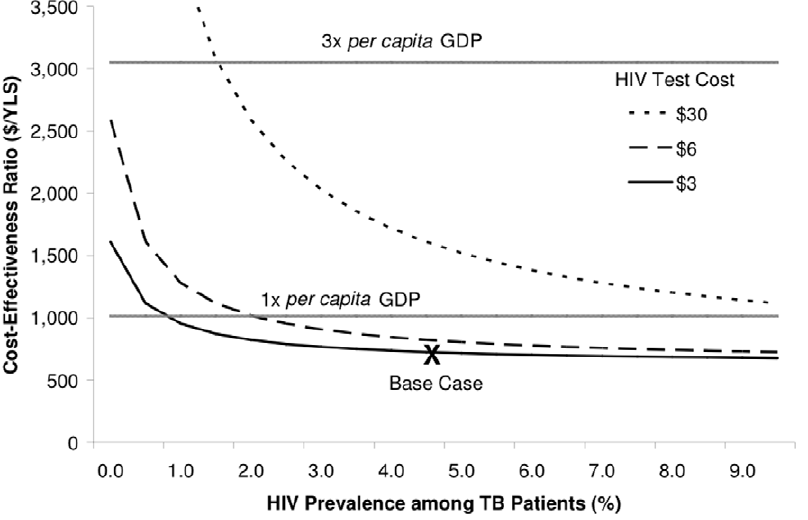
Figure 1. Sensitivity analysis on HIV prevalence among TB patients. The cost-effectiveness of routine referral for HIV testing for all TB patients (Strategy 3) compared to the current standard of referral for HIV testing for TB patients in the nine states with the highest HIV prevalence and selective referral elsewhere (Strategy 2), as a function of HIV prevalence and HIV test cost. The 3x and 1x per capita GDP for India represent thresholds for ‘‘cost-effective’’ and ‘‘very cost-effective’’ health care interventions, as recommended by the WHO (See Methods). GDP: Gross Domestic Product; YLS: Year of life saved. doi:10.1371/journal.pone.0012747.g001 PLoS ONE |